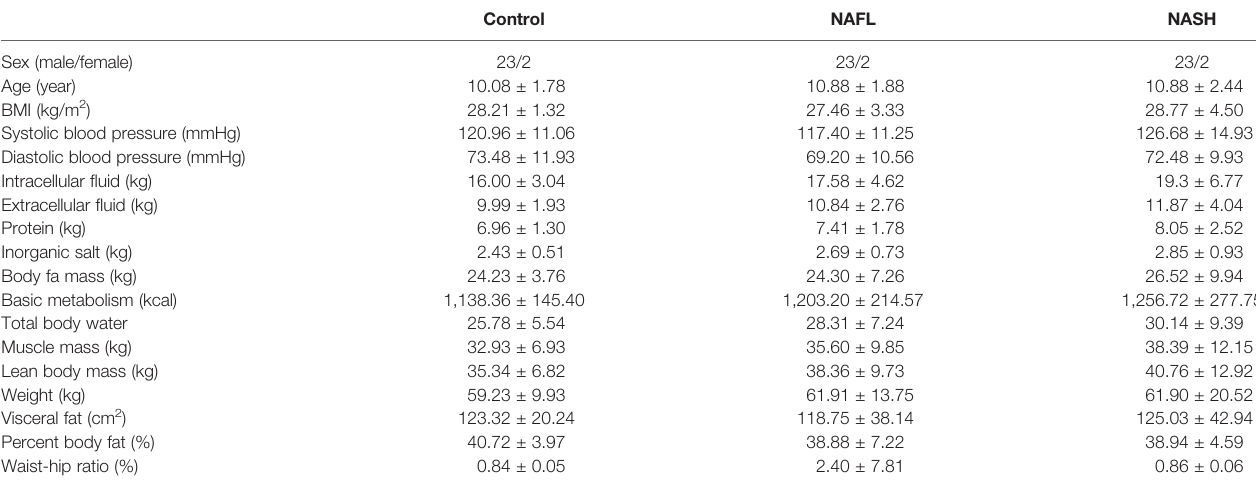
TABLE 1 | Anthropometric and demographic data in different